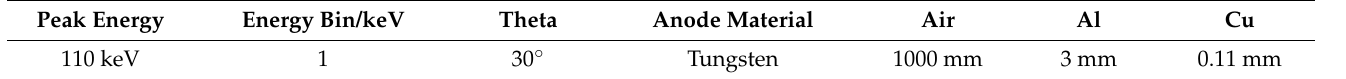
Table 1. Parameters for the energy spectrum.